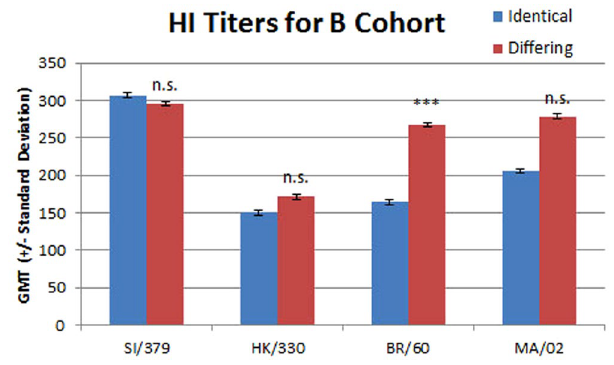
Figure 4. The geometric mean titers for sera from the identical and differing groups in the B virus cohort are shown with standard deviations. The viruses used are listed on the x axis: SI/379, B/Sichuan/379/1999 (Yamagata); HK/330, B/Hong Kong/330/2001 (Victoria); BR/60, B/Brisbane/60/2008 (Victoria); and MA/02, B/Massachusetts/02/2012 (Yamagata). The difference between the identical and differing groups was evaluated using the Mann Whitney rank test. n.s., not significant; and *** p ≤